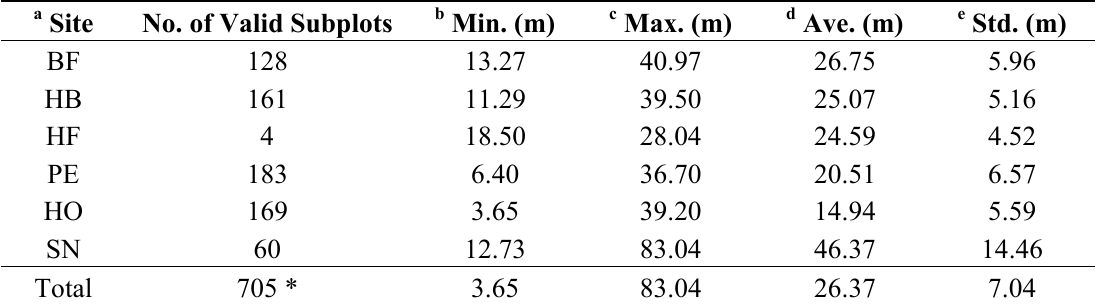
Table 3. Statistics of valid subplots and field-measured heights corresponding to LVIS